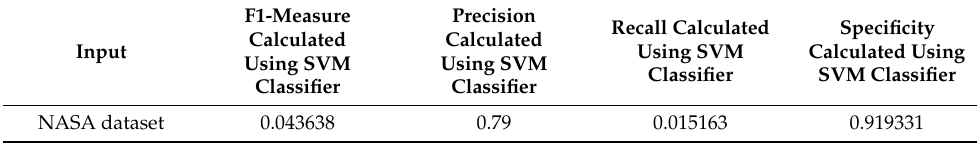
Table 2. F1-measure, Precision, Recall, and Specificity Calculation Table (Using